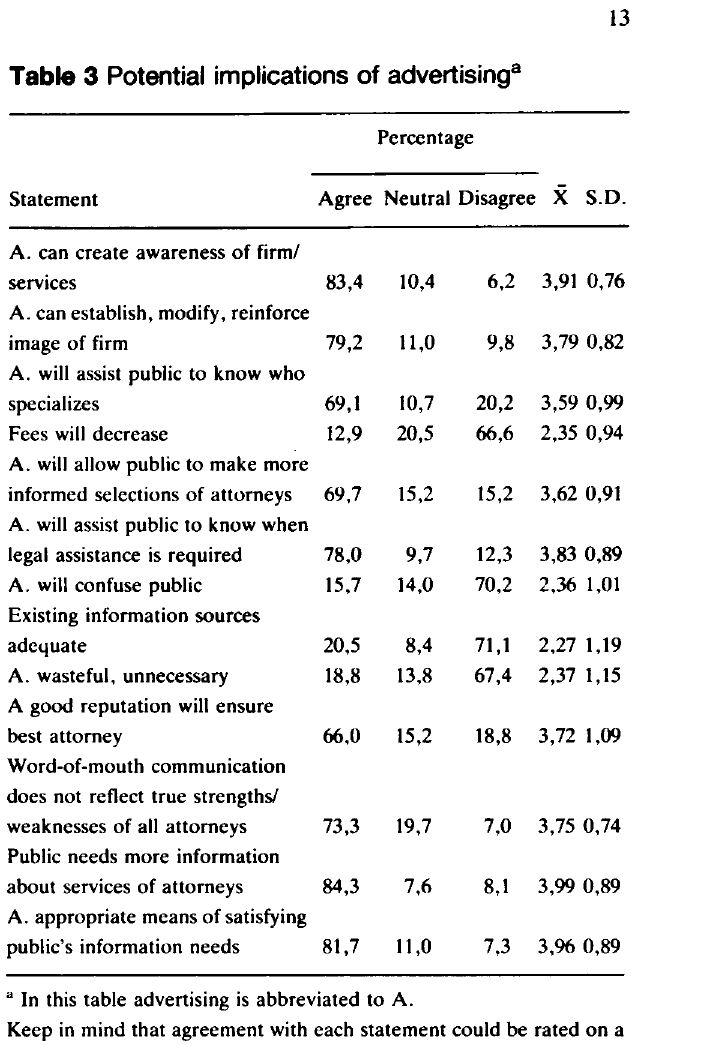
Table 3 Potential implications of advertising